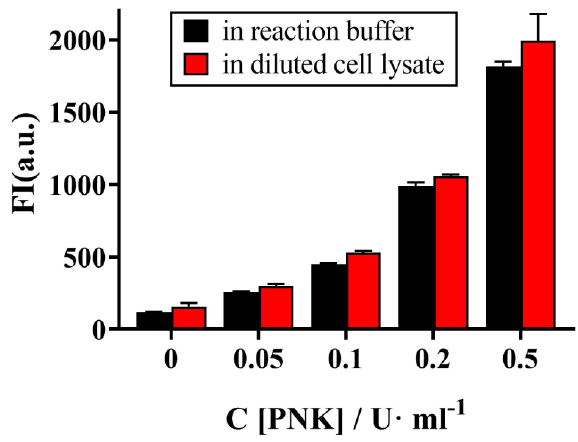
Figure 6. Fluorescence intensity for the label-free detection of T4 PNK activity based on the ligation-triggered transcription in reaction buffer and diluted cell lysates spiked with different concentrations of T4 PNK. The error bars represent the standard deviation (SD) across three repetitive experiments. 4. Conclusions In summary, we herein developed a simple fluorescence sensing system for T4 PNK activity detection and inhibitor screening by combining a designed ligation-triggered T7 transcription system and a light-up MGA. This system shares several distinct